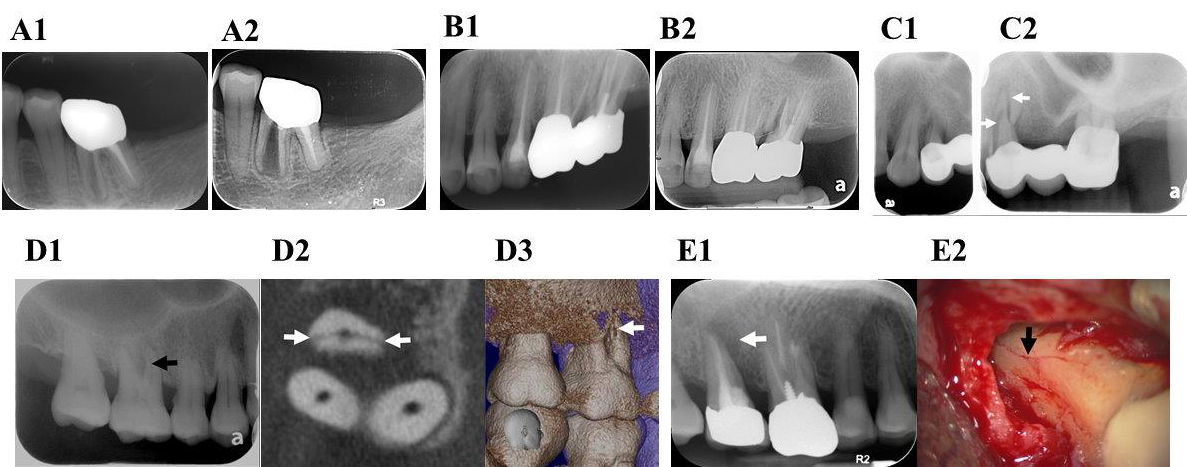
Figure 2. Diagnostic methods of vertical root fracture (VRF). ( A1 ) 75-year-old female with VRF of the 36th mesial root in July 2018. The radiograph showed root displacement, but no periodontal pocket or soft tissue swelling. ( A2 ) Swelling in the lingual side with deep pocket was noted over the 36th on the lingual side in April 2021; ( B1 ) VRF of the 27th mesiobuccal root was noted on the periapical radiograph, but no swelling, periodontal pocket, or other symptoms were present in 2019. ( B2 ) No symptom, soft tissue swelling, or deep pocket were noted even after follow-up for 2 years in March 2021. ( C1 ) The maxillary left first premolar did not show obvious VRF in this radiograph. ( C2 ) From another angle, the fracture lines were evident (white arrows). ( D1 ) Radiographic image of the maxillary right first molar. There was suspicious widening of the root canal at the mesiobuccal root (black arrow). ( D2 ) After performing CBCT, a fracture line was observed at the mesiobuccal root (white arrows). ( D3 ) The recombination image also showed a VRF in the mesiobuccal root (white arrow). ( E1 ) Radiographic image of maxillary right second molar with periradicular radiolucency (white arrow). ( E2 ) After surgical intervention, VRF was observed on the root surface under microscope (black arrow).